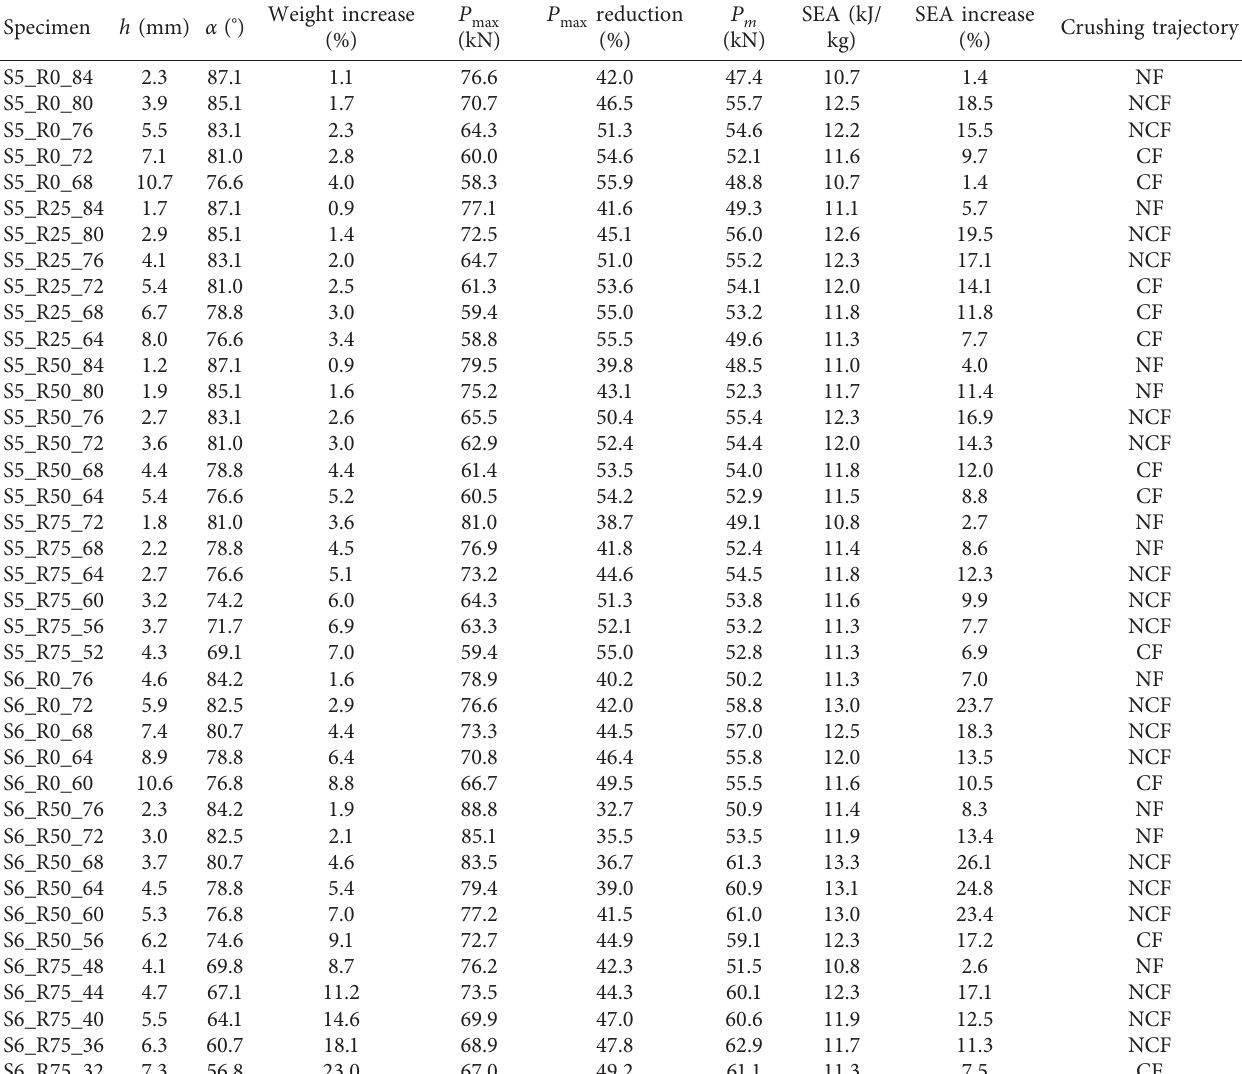
Table 2: Geometries and numerical results of the supplemental square patterned tubes for the analysis of ratio R .